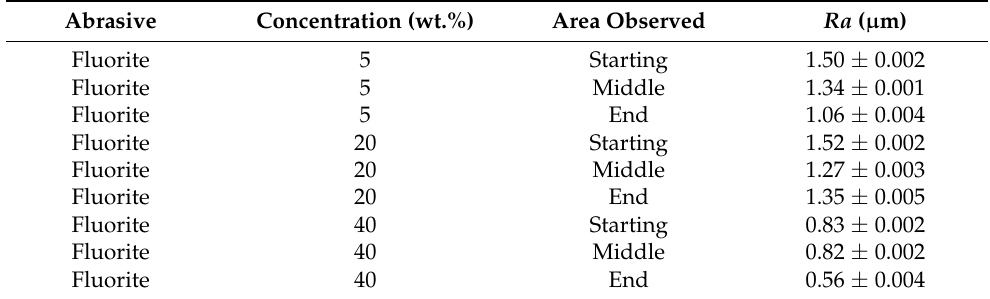
Table 7. Roughness of AISI 4145H steel after being abraded by slurry with dolomite.